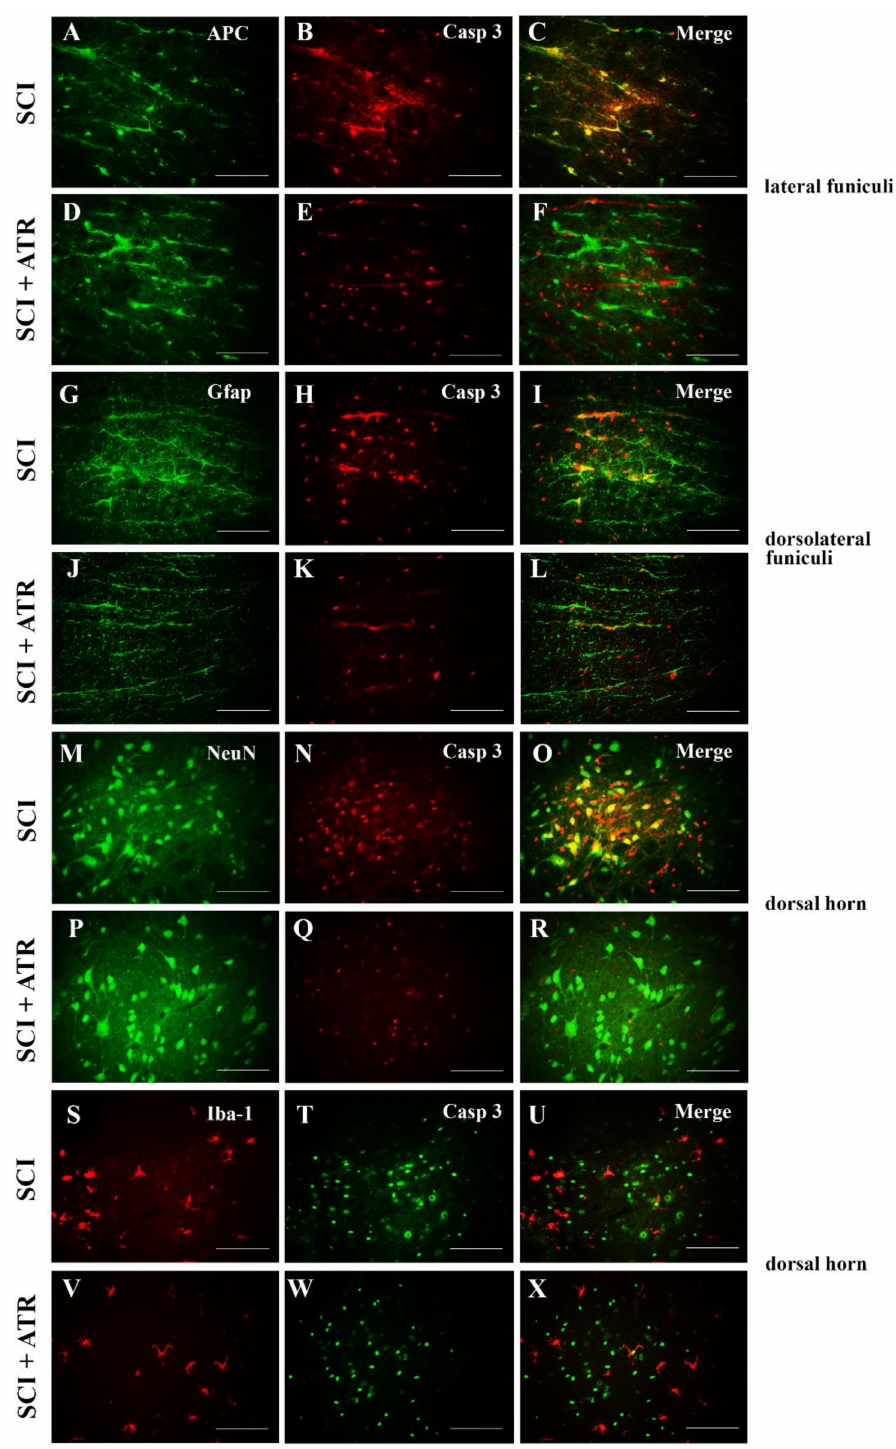
Figure 5. Set of microphotographs showing the immunofluorescent staining and co-localization of caspase-3 (red in B,E,H,K,N,Q; green in T,W) with APC (green), GFAP (green), NeuN (green), and Iba-1 (red) one day after the SCI and the ATR treatment. Double immunostaining demonstrates the cleavage of caspase-3 in the oligodendrocytes ( A – F ); astrocytes ( G – L ); neurons ( M – R ); and microglial cells ( S – X ) 0.5 cm caudally from the lesion site in the SCI and SCI + ATR groups. Scale bars: ( A – X —100 µ m). APC—adenomatous polyposis coli positive mature oligodendrocytes; ATR—Atorvastatin; Casp 3— caspase-3; GFAP—astrocytes, Iba-1—microglia; NeuN—neurons; SCI—spinal cord